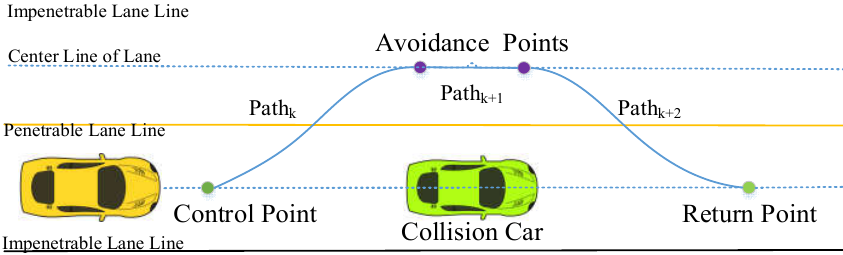
Figure 11. Detection of collision car and avoidance points.